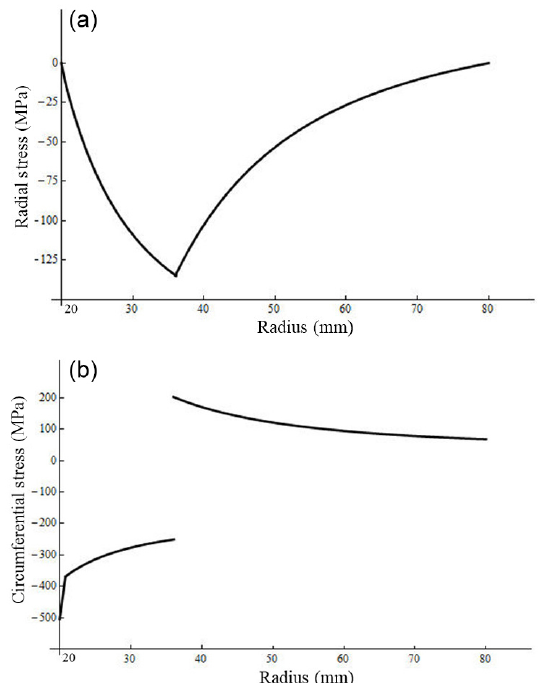
Figure 3. Distributions of (a) radial and (b) circumferential residual stresses obtained from theoretical